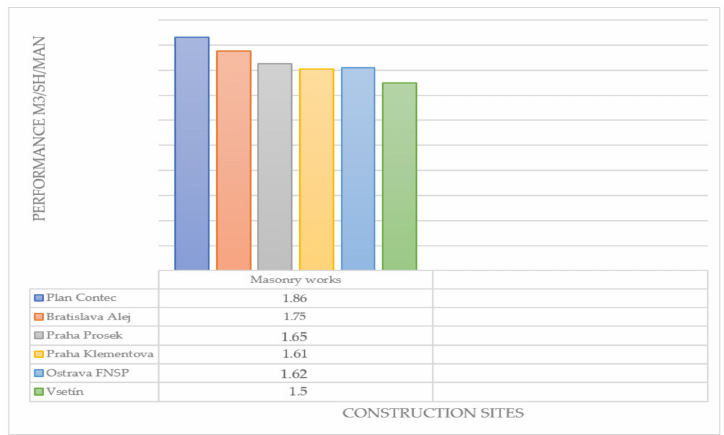
Figure 18. Comparison of plastering works